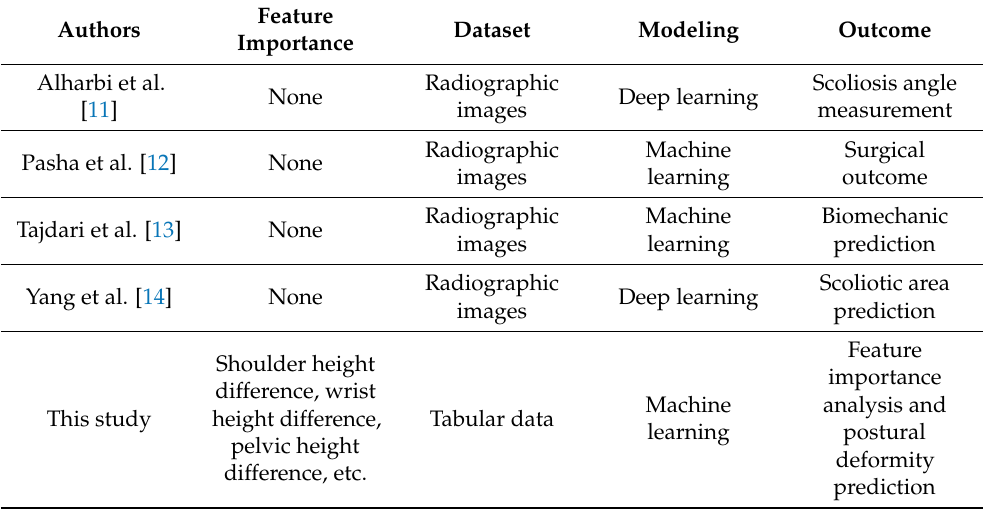
Table 1. Artificial intelligence research using feature importance analysis to detect spinal